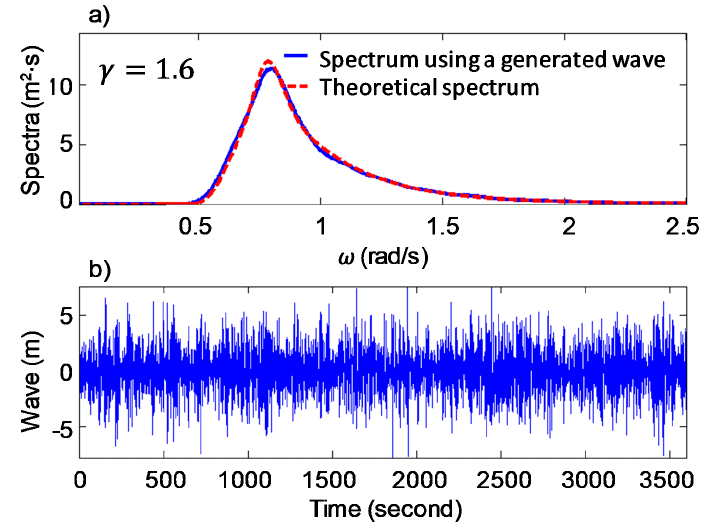
Figure 3. Comparison of the irregular wave height: ( a ) comparison between generated wave spectrum and theoretical spectrum, ( b ) irregular wave height (m) at the node located in the middle of the open boundary line.